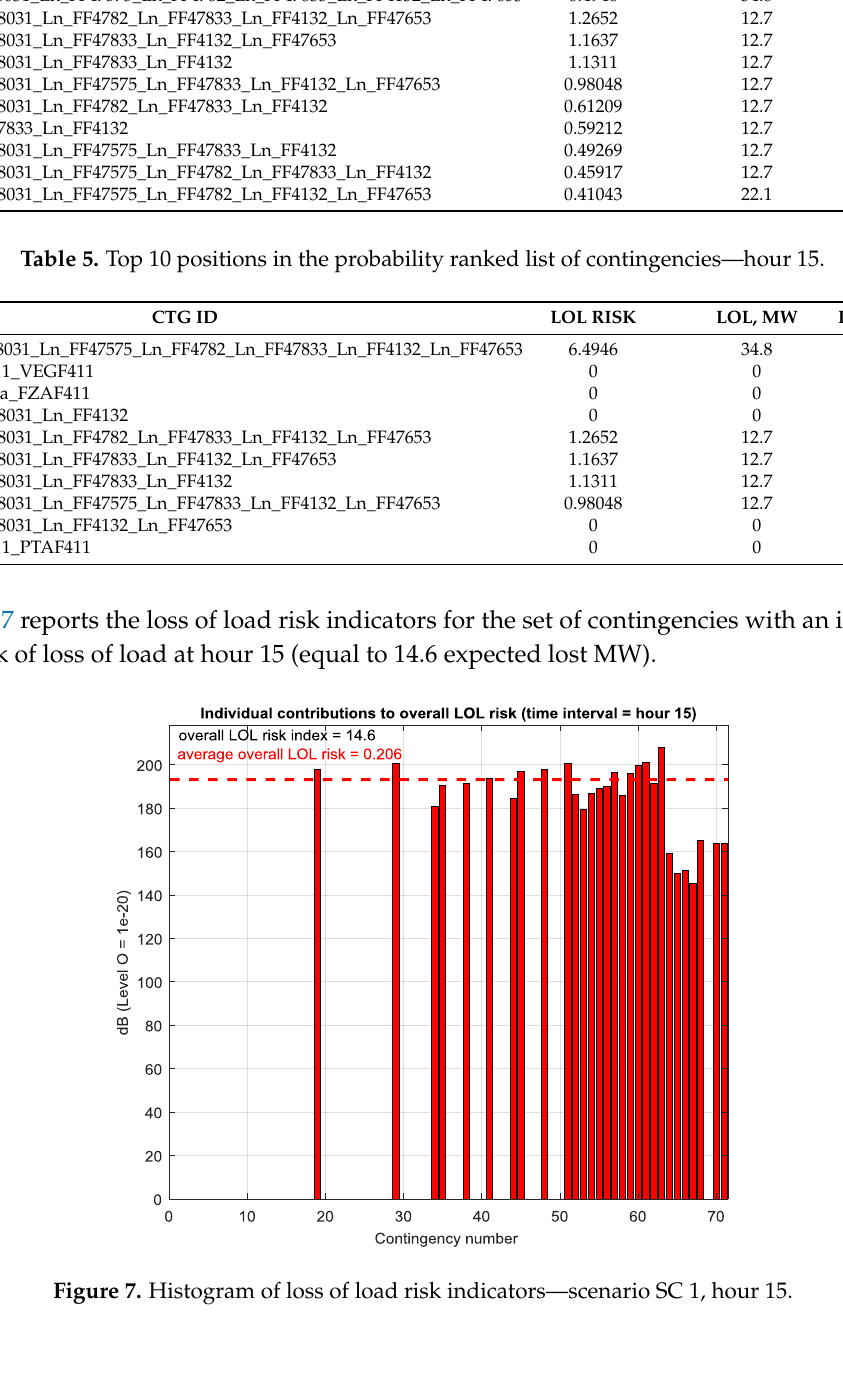
Table 4. Top 10 positions in the risk ranked list of contingencies − hour 15.